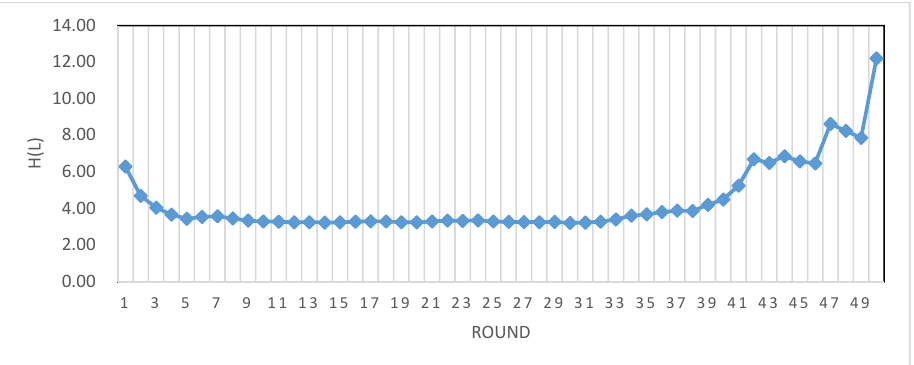
Figure 9. Entropy of all Nls values with different radiuses from round 1 to round 50.